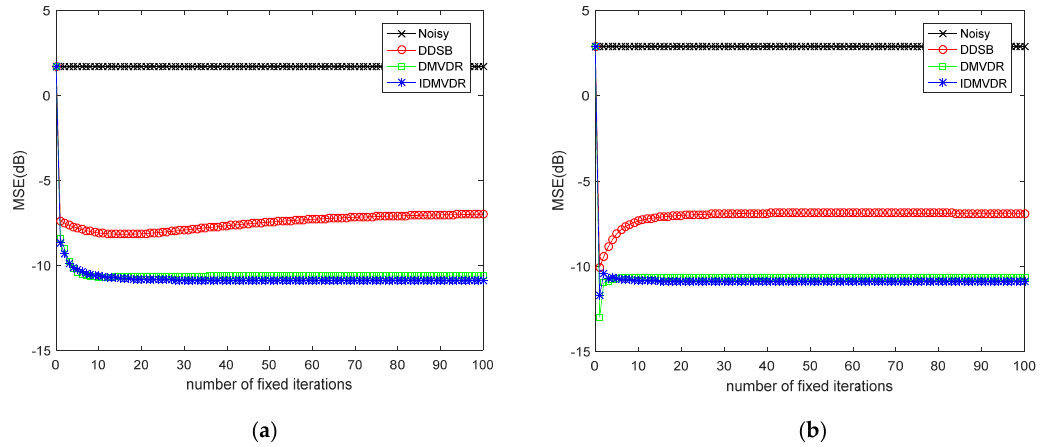
Figure 8. The MSE variations in the WASN with N d = 20: ( a ) MSE of node 8 in each iteration; ( b ) MSE of node 2 in each